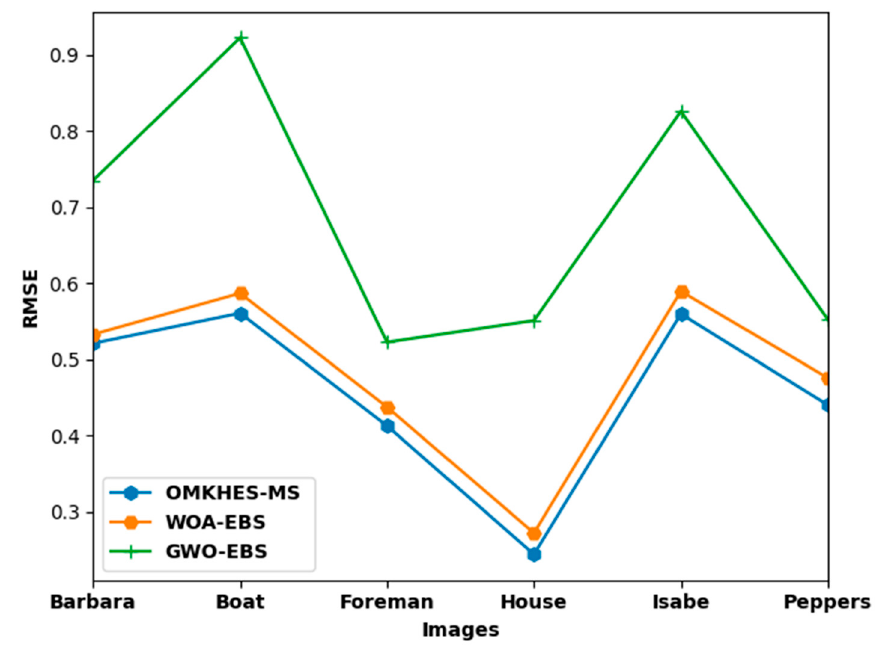
Figure 7. Comparative RMSE analysis of OMKHES-MS technique with existing models.